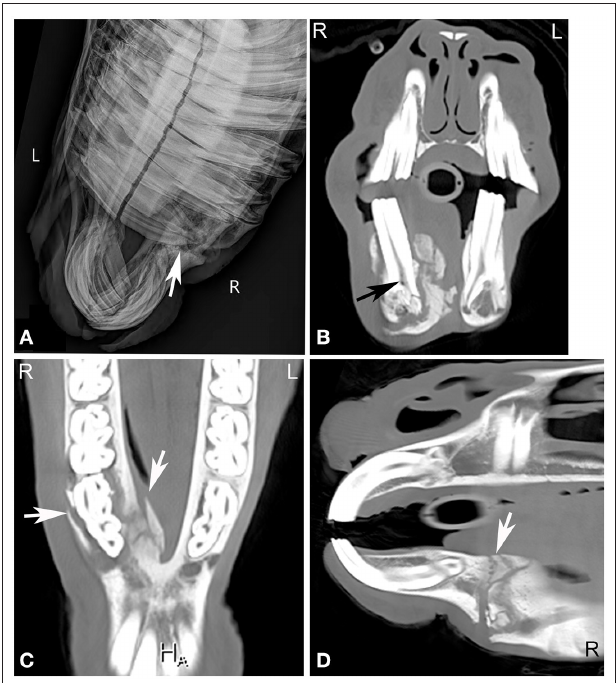
FIGURE 8 | Dentigerous cysts. Computed tomography images of the caudal aspect of the head of a 2-year-old Morgan gelding with a history of a draining tract of 4–5 months duration by the right ear. Transverse (A,C) , dorsal (B) , and 3-dimensional (D) CT images reveal three abnormally positioned and abnormally shaped tooth-like structures at the base of the right ear with remodeling of the right temporal and occipital bones consistent with dentigerous cysts. Two of these tooth-like structures have their roots extending toward the calvarium but no neurologic abnormalities were reported. L, left; R, right.